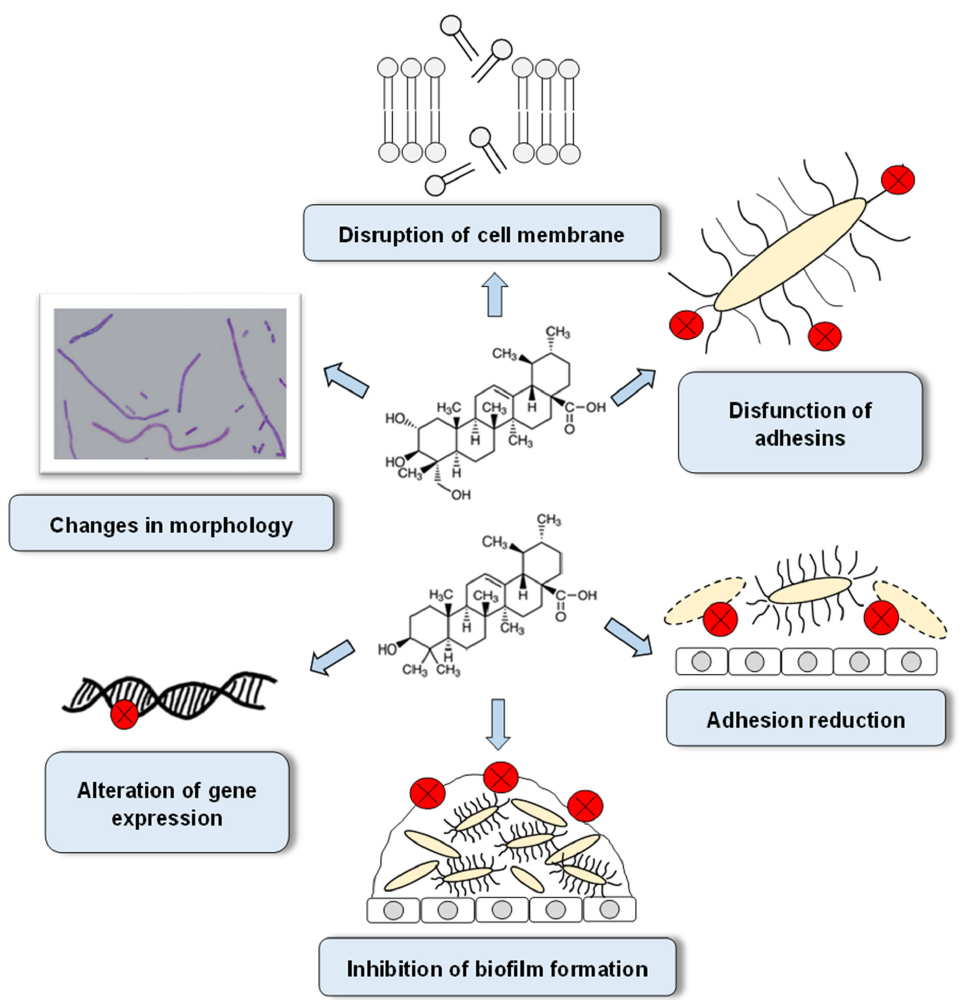
Figure 2. The various antibacterial targets of asiatic and ursolic acids.